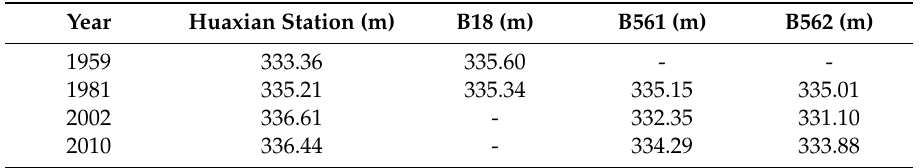
Table 2. Annual average water level at the Huaxian Station and groundwater level at B18, B561, and B562 in 1959, 1981, 2002, and 2010.